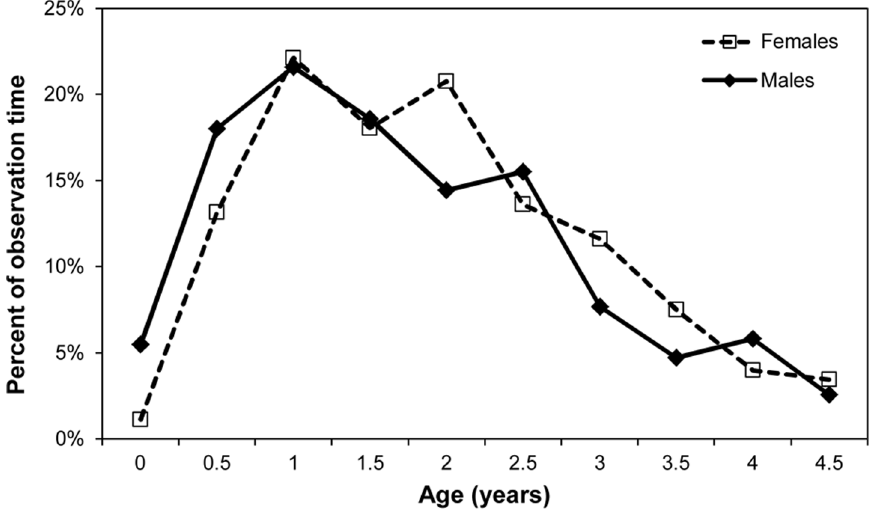
Figure 2. Mean percent of observation time spent in solitary play for male and female infants.